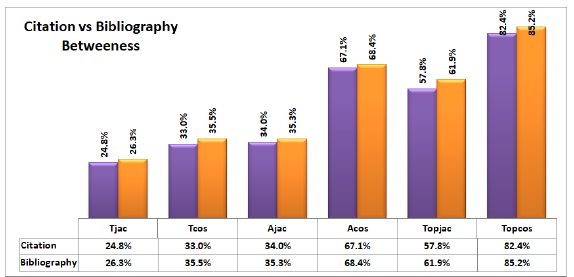
Figure 3. Comparison Between Citation and Bibliography Through Betweeness